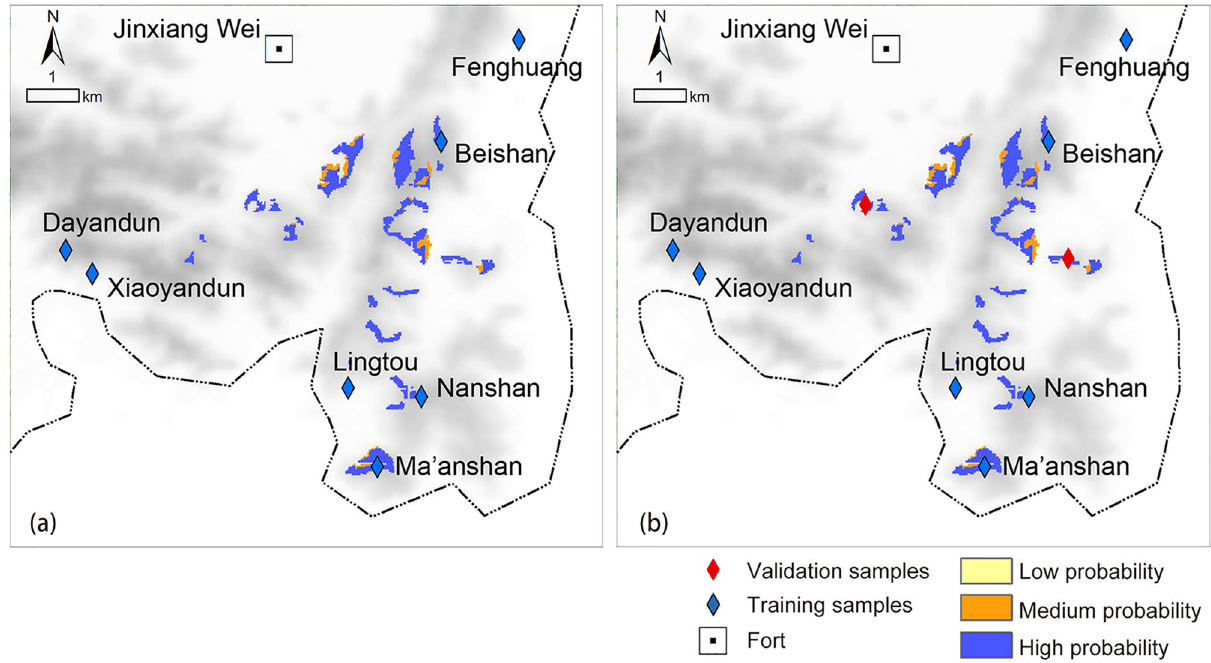
Figure 9. Final prediction result in the Jinxiang Wei area: ( a ) the prediction result; ( b ) validation result (generated by the authors using ArcGIS